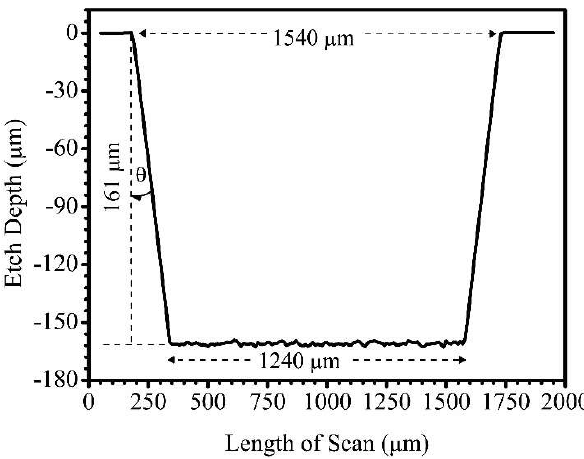
Figure 3. Line profile scan of FLMP etch area (1500 µ m × 1500 µ m) machined into borosilicate glass substrate at PS CNC of 0.1 mm / s and LF av of 329.06 J / cm 2 . The profile was recorded at 5 µ m / s, 10 Hz, and 2 mg applied force. The inclined etch surfaces make a contact angle (θ) of ~ 8° with the vertical plane.